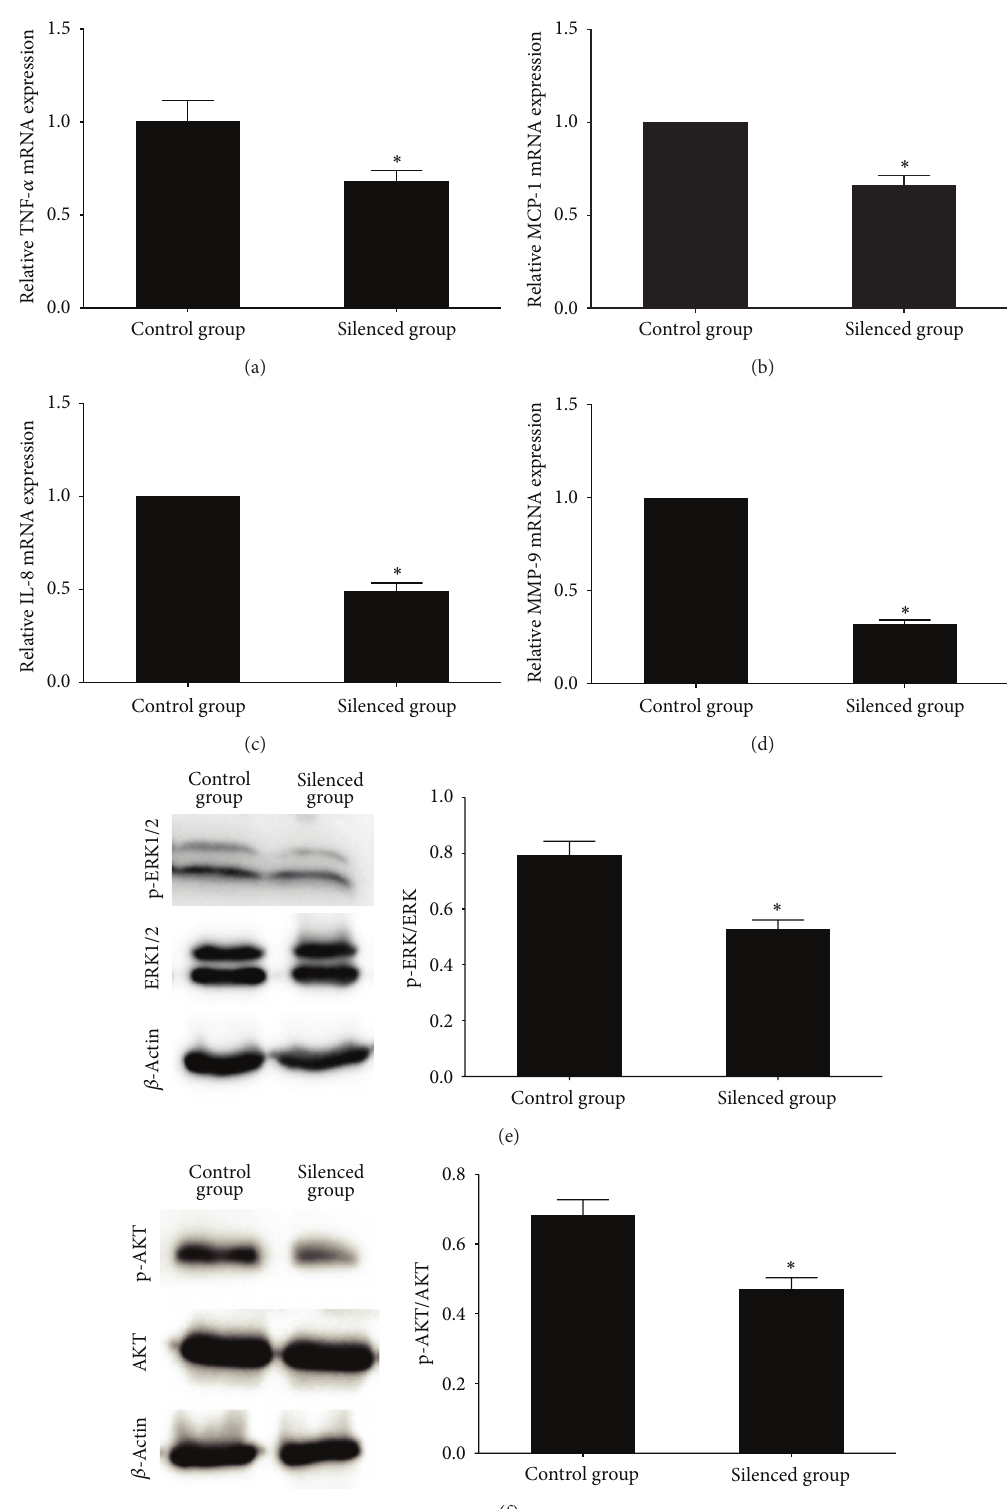
Figure 4: (a)–(d) Real-time RT-PCR quantification of inflammatory cytokines mRNA expression in mice carotid plaques in control group andsilencedgroup.ThesilencedgroupshowedlowermRNAexpressionlevelsofTNF- 𝛼 ,MCP-1,IL-8,andMMP-9,comparedwiththecontrol group, and inhibition of CHI3L1 reduced the inductions of proinflammatory cytokines. (e)-(F) Western blot analysis and quantification of ERK1/2, phospho-ERK1/2, AKT, and phospho-AKT protein expression in control group and silenced group. The protein expression levels of phospho-ERK1/2 and phospho-AKT were decreased in silenced group compared with that in control group. ∗ 𝑃 < 0.05 versus control